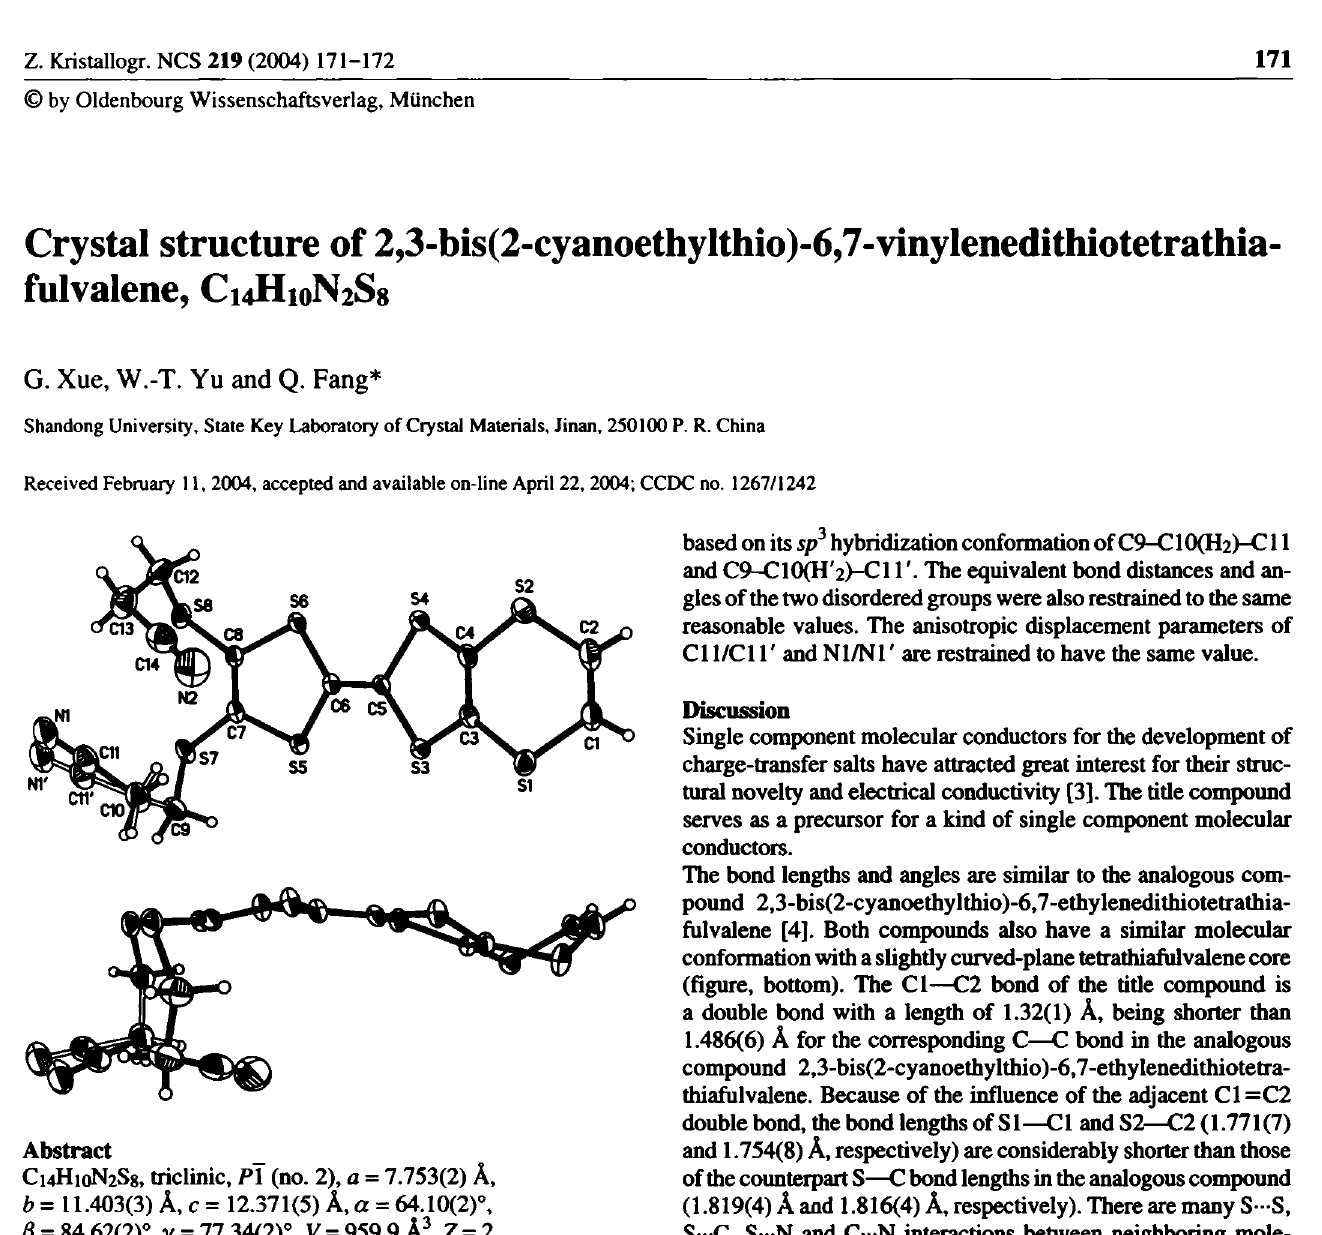
Table 1. Data collection and